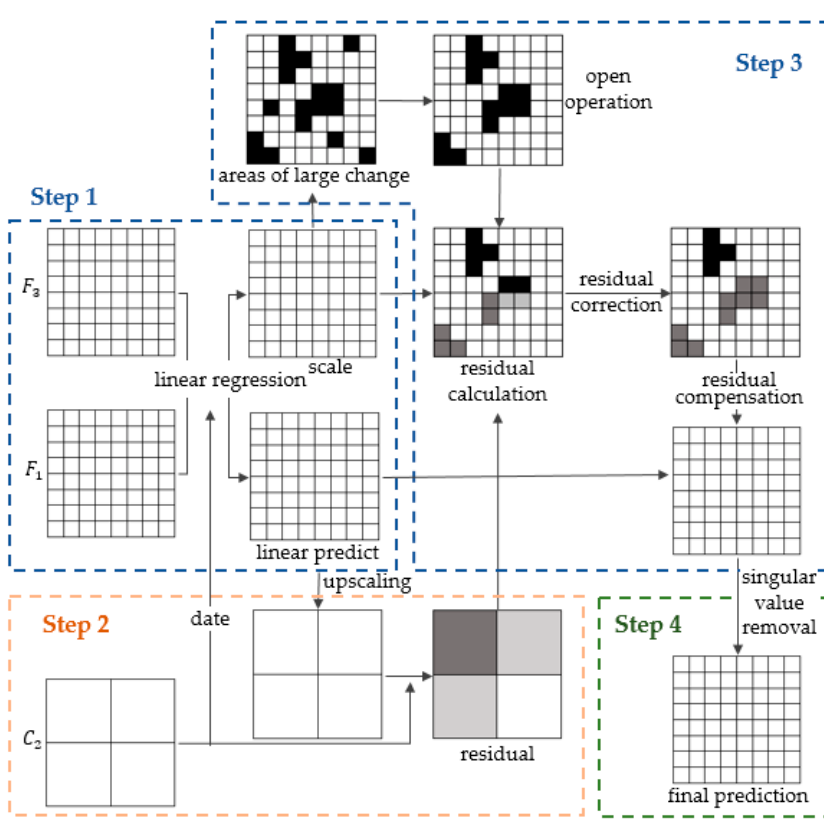
Figure 3. Flowchart of the ELRFM.